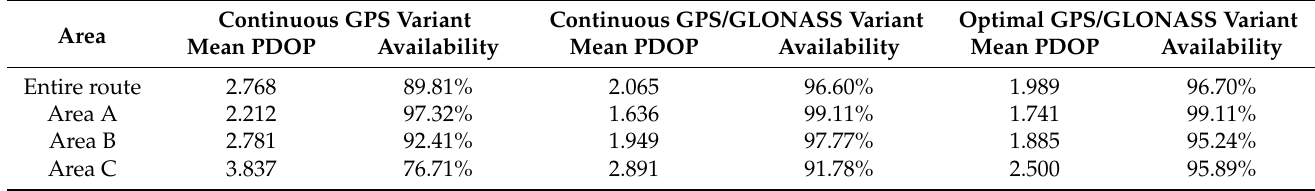
Table 4. The average values of the PDOP, obtained during simulation tests for the second measurement campaign.